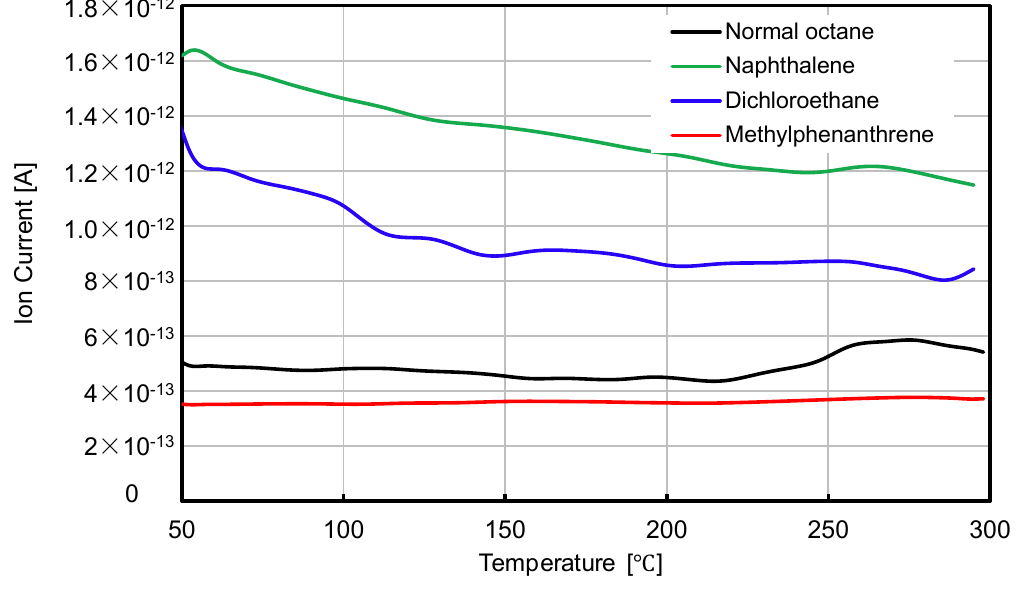
Figure 5. VOC volatile speed of non-modified bituminous